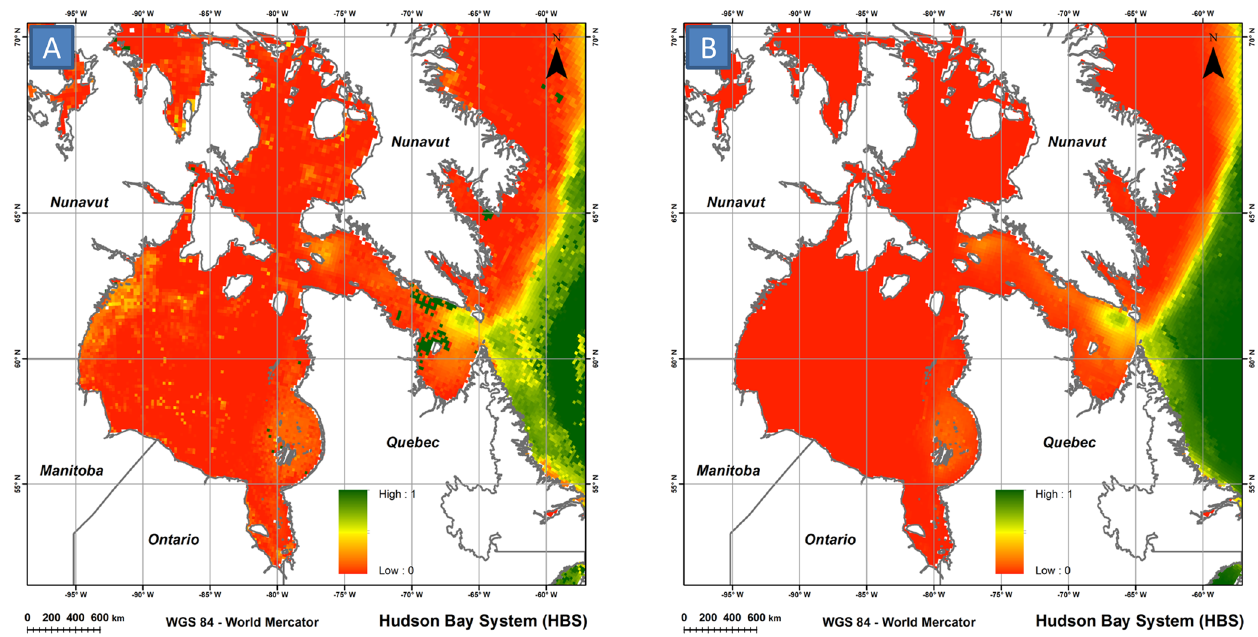
Figure 4. Comparison of IcePAC results for non-systematic (i.e. based on Mann–Kendall test result) trend removal (a) and systematic trend removal (b) , on the resulting map for the probability of observing a SIC < 50% on week 1.